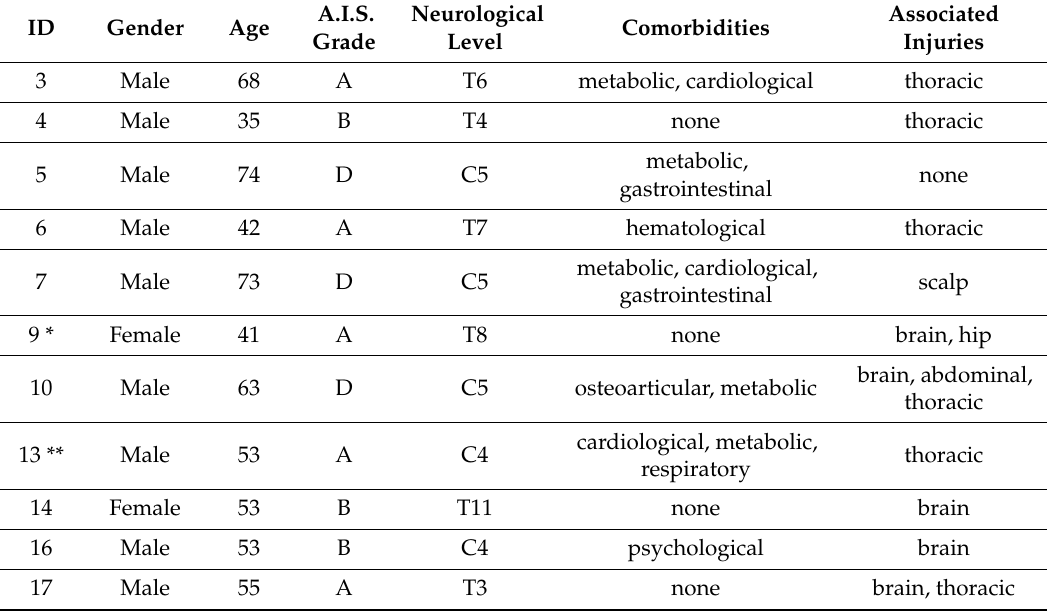
Table 1. Characteristics of study participants: sex, age, comorbidities, trauma associated with the event cause of SCI, neurological level of injury (NIL) and AIS score at T0.